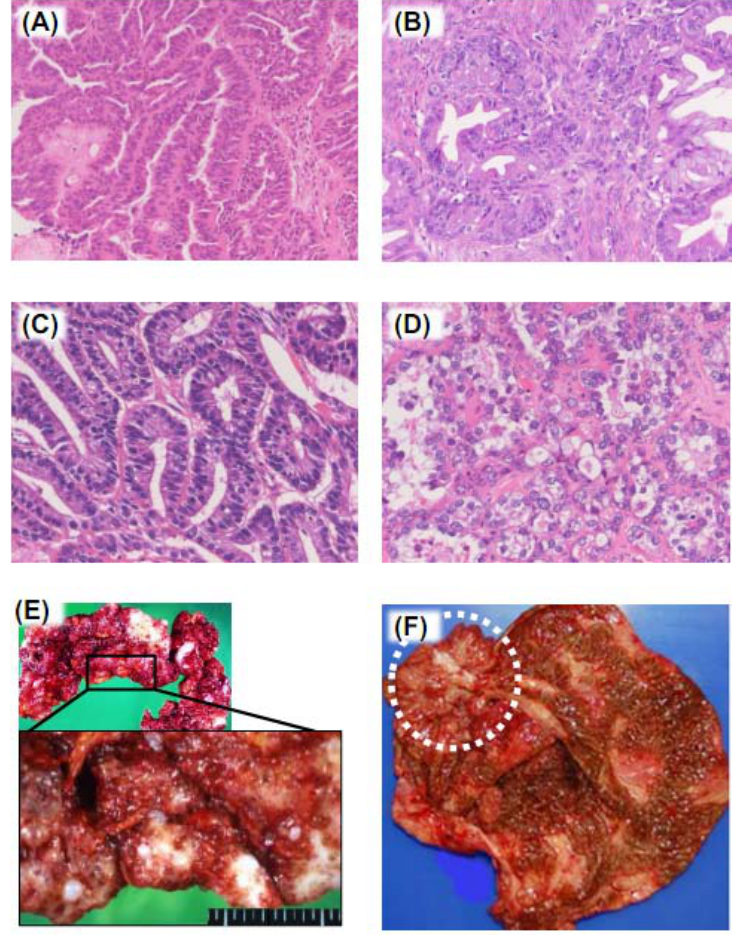
Figure 2. Histologic types of ovarian cancers. ( A ) Serous adenocarcinoma. The tumor shows papillary structure, and the cells do not contain intracytoplasmic mucin; ( B ) Mucinous adenocarcinoma. Irregular glands are composed of cell with atypical nuclei and intracytoplasmic mucin; ( C ) Endometrioid adenocarcinoma. The histology closely resembles endometrioid adenocarcinoma of the uterine corpus; ( D ) Clear cell adenocarcinoma. The cells have clear or eosinohpilic cytoplasm, protruding into glandular lumen; ( E ) Macroscopic feature of peritonitis carcinomatosa. The omental fat is completely replaced by metastatic cancer; ( F ) Macroscopic feature of EAOC in a chocolate cyst. Circle indicates cancer